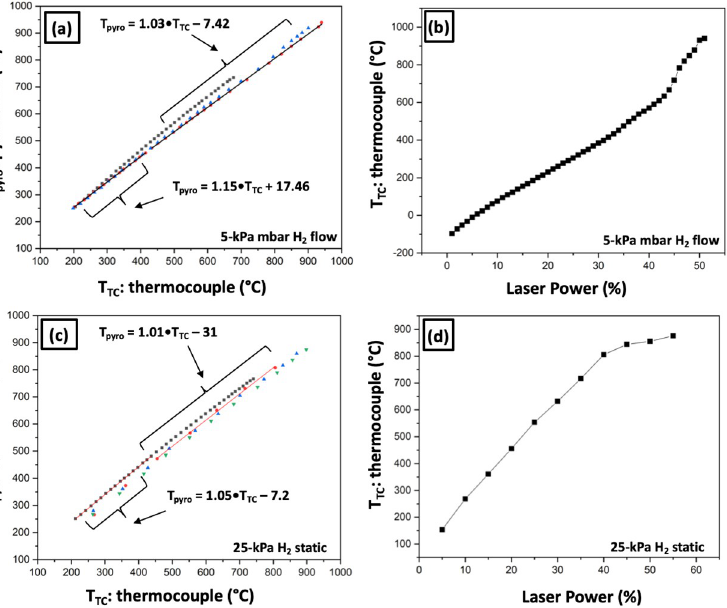
Fig 5. Pyrometer-thermocouple calibrations. Calibration curves for the Reacthub 304SS samples grid in two types of hydrogen atmospheres. (a) The pyrometer vs thermocouple calibration curve for three consecutive heating experiments in a continuous 5-kPa H 2 flow. (b) The corresponding laser power vs thermocouple reading curve (1 st cycle). (c) The pyrometer vs thermocouple readings for three consecutive heating experiments in a static 25-kPa hydrogen. (d) The corresponding laser power vs thermocouple reading curve (1 st